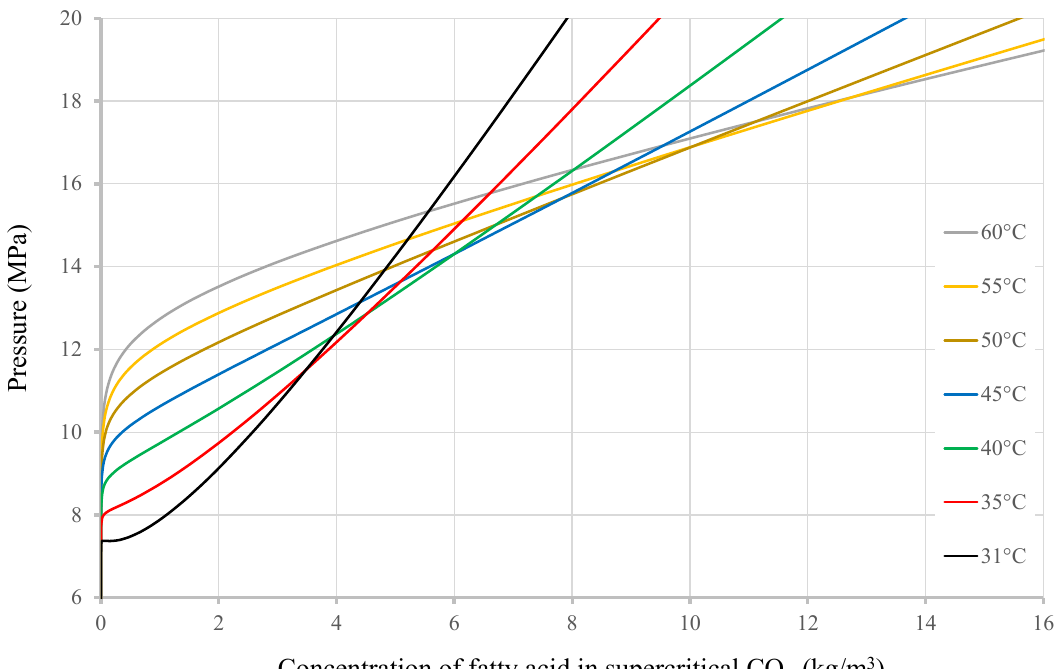
Figure 3. Example of solubility in scCO 2 calculated using average parameters for six fatty acids ( A 1 = − 21.7, A 2 = − 8211, A 3 = 7.48).